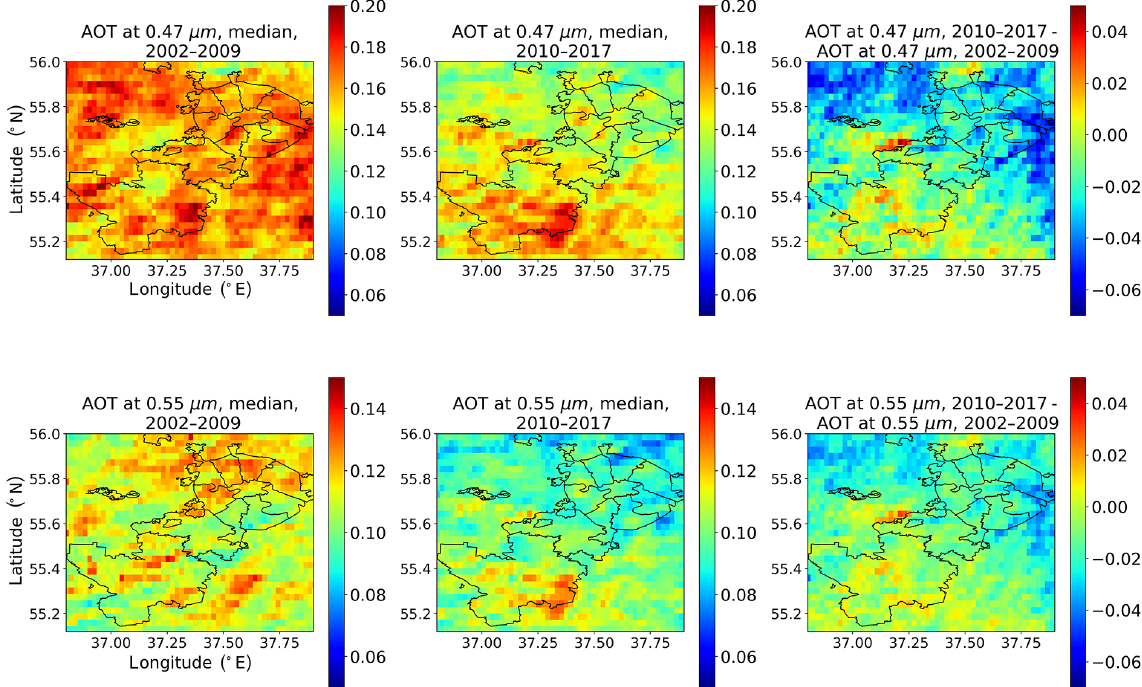
Figure 9. AOT MAIAC at 0.47µm and AOT at 0.55µm median values for the 2002–2009 and 2010–2017 periods and their